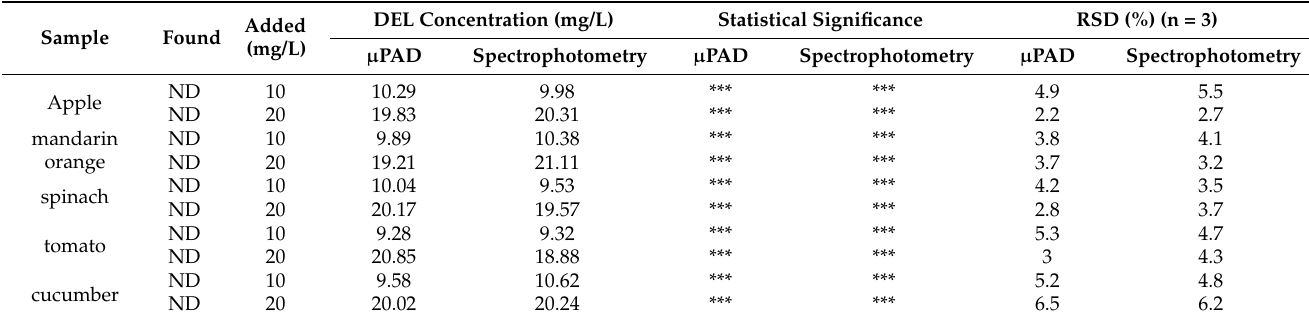
Table 1. Comparison of DEL detection results in various fruits and vegetables using the µ PAD versus the spectrophotometry (ND, undetectable and *** p < 0.001 compared to untreated samples